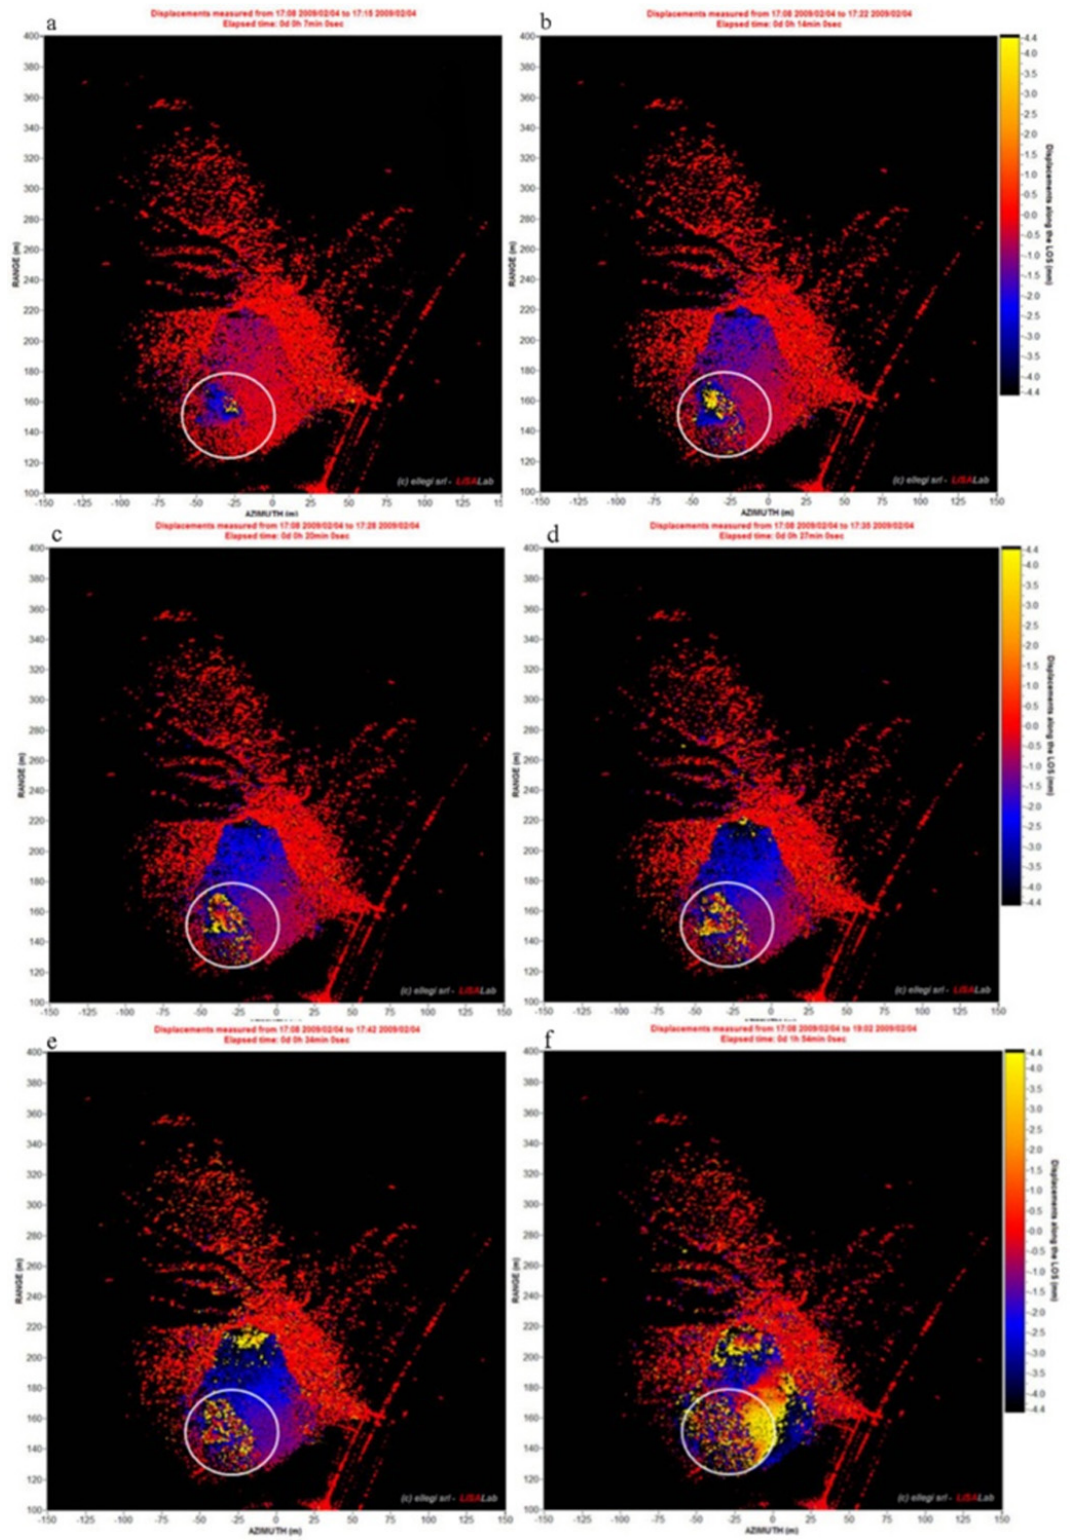
Fig. 10. Mosaic of incremental interferograms starting from 5:08 p.m. of 4 February 2009. The time intervals for each interferogram are respectively: (a) 7min; (b) 14min; (c) 20min; (d) 27min; (e) 34min; (f) 1h and